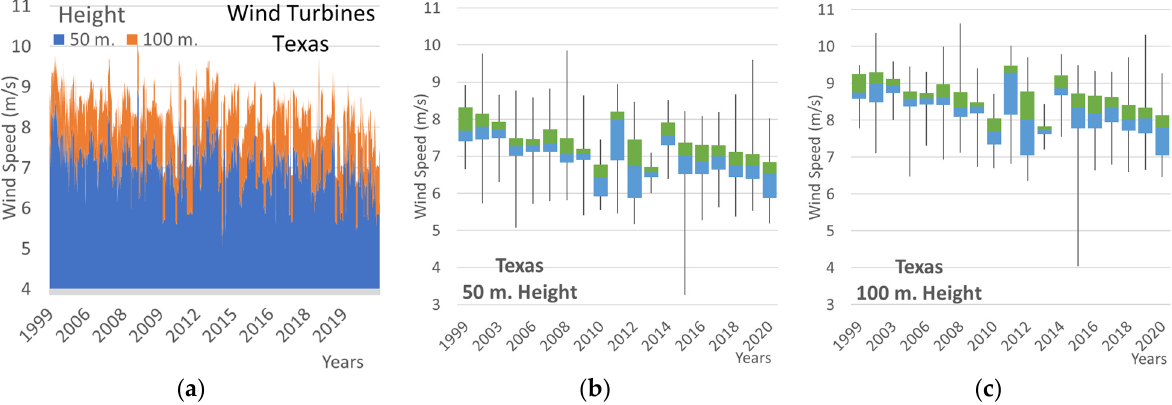
Figure 11. Wind speed corresponding to the location of wind turbines installed in Texas over the last two decades at 50 and 100 m height: ( a ) Stacked area, ( b ) box plot at 50 m height and ( c ) box plot at 100 m height.